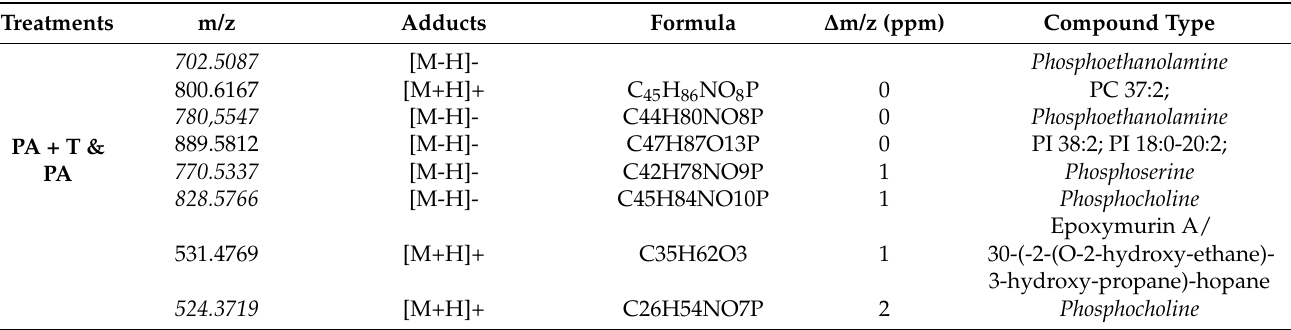
ported every match in Supplementary Tables S2 – S4. Nonetheless, 40% of metabolites were